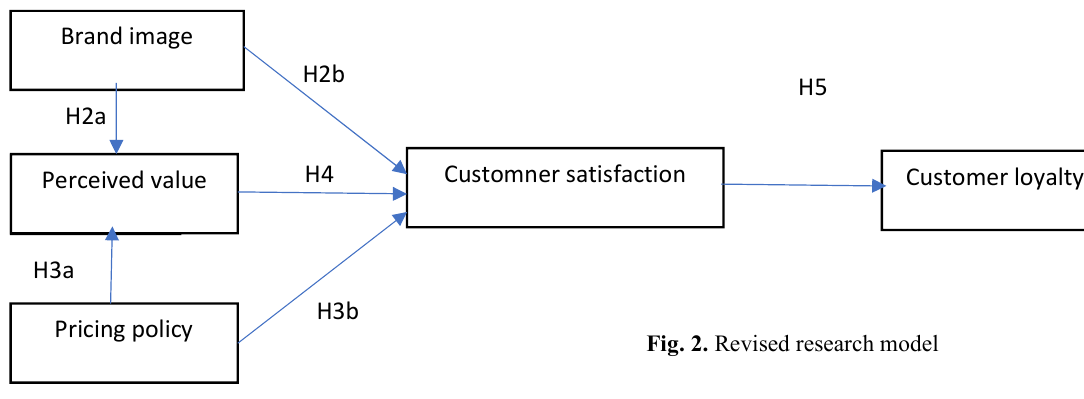
Fig. 2. Revised research